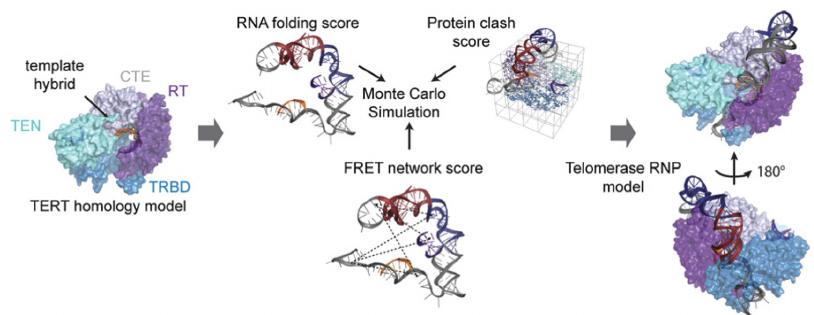
Figure 8. Workflow to derive structural models of higher quality by incorporating the FRET network score into Rosetta modeling. With existing structural data from homology models, the authors combined restraints obtained from RNA folding, steric calculations and smFRET data into a novel model of the hTR-TERT RNP. This Figure is taken from Parks et al. and used under Creative Commons Non-Commercial License (CC-BY NC).